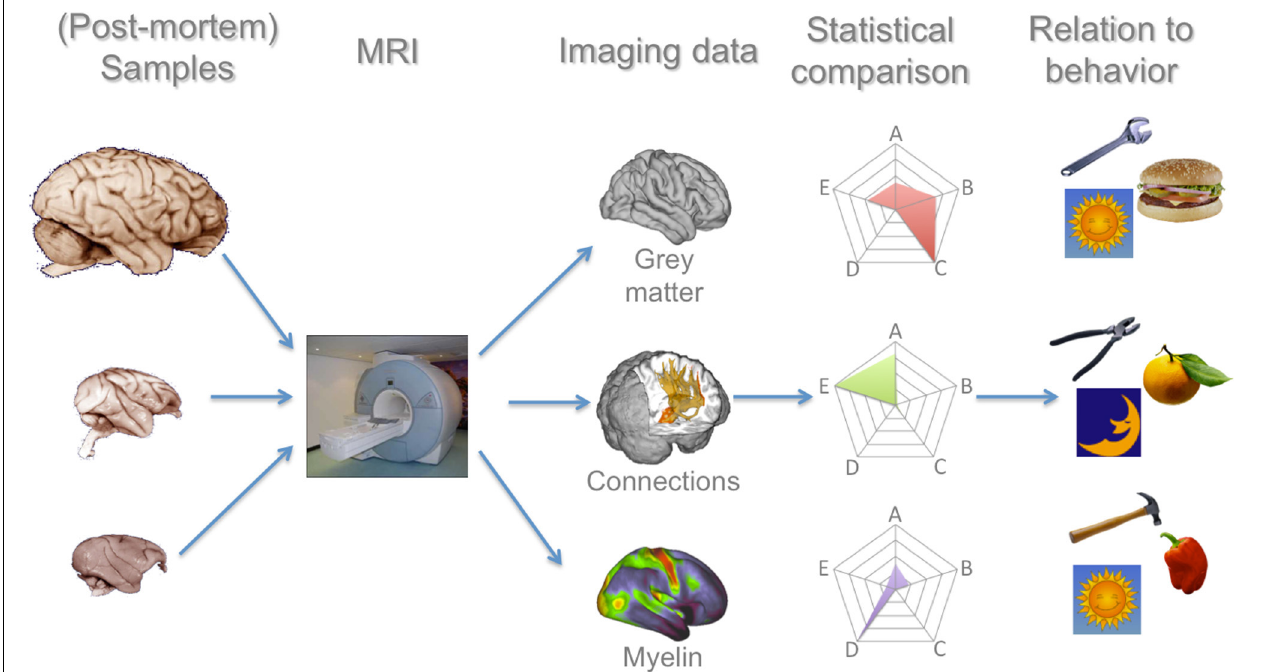
FIGURE 1 | Processing pipeline for a comparative primate neuroimaging research program. In this manuscript we argue that each of these steps have seen recent advances that now allow such a program to be realistically feasible. MRI of whole-brain (post-mortem) samples allows a number of measures to be collected, for which comparative analysis techniques have now been developed and validated. These data can then be related to the